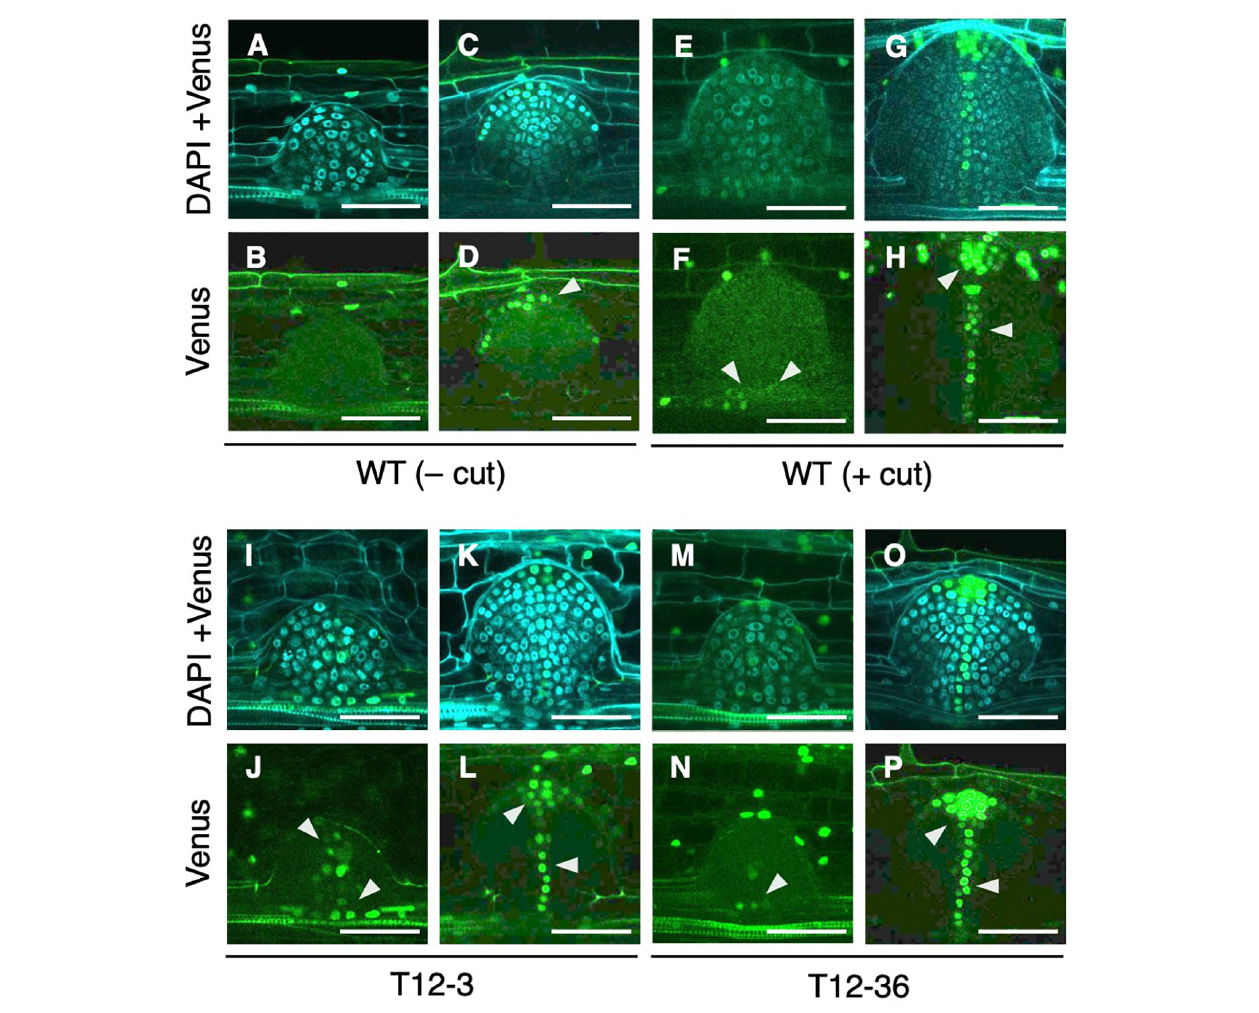
FIGURE 4 | Analysis of auxin signaling distribution in lateral root primordia (LRP) of wild-type (WT) and the mutants. LRP observed in transverse section of crown roots expressing DR5-NLS-3xVENUS in the background of WT (A–H) , T12-3 (I–L) , and T12-36 (M–P) . In the WT, S-type LRP without root tip excision (– cut; A–D ) and L-type LRP with root tip excision (+ cut); 15 h in (E,F) ; 24 h in (G,H) are shown. In the mutants, L-type LRP without root tip excision are shown. For each genotype/treatment, LRP before (A,B,E,F,I,J,M,N) and after (C,D,G,H,K,L,O,P) meristem formation is shown. Venus signals and its merged images with DAPI signals are shown. Arrowheads point the Venus signals in LRP. Scale bars = 50 µ